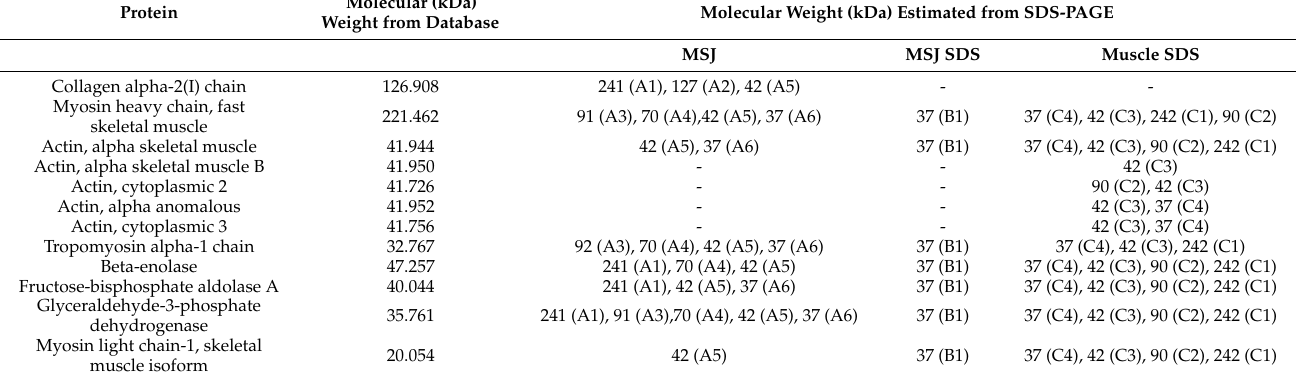
Figure 3. Sequences of myosin heavy chain (fast skeletal muscle; SwissProt: Q90339). Matching tryptic peptides to MSJ band A4 (Figure 1) were marked in red letters. Table 2. Summary of proteins identified from mackerel steaming juice (MSJ), MSJ and mackerel meat SDS extract by SDS-PAGE and LC-MS/MS analysis.